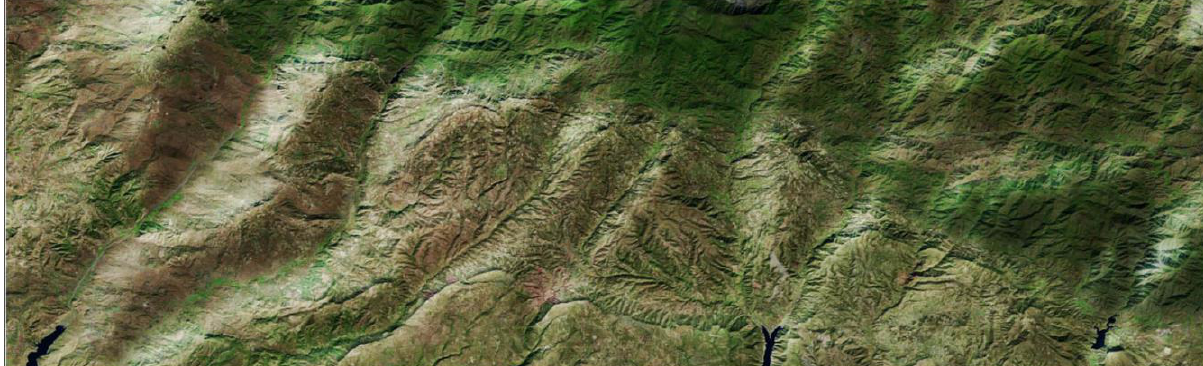
Figure 5. Connection of NASA_P image with SRTM-30. Full resolution reduced twice to show greater area (scale 1:400 000 approx)